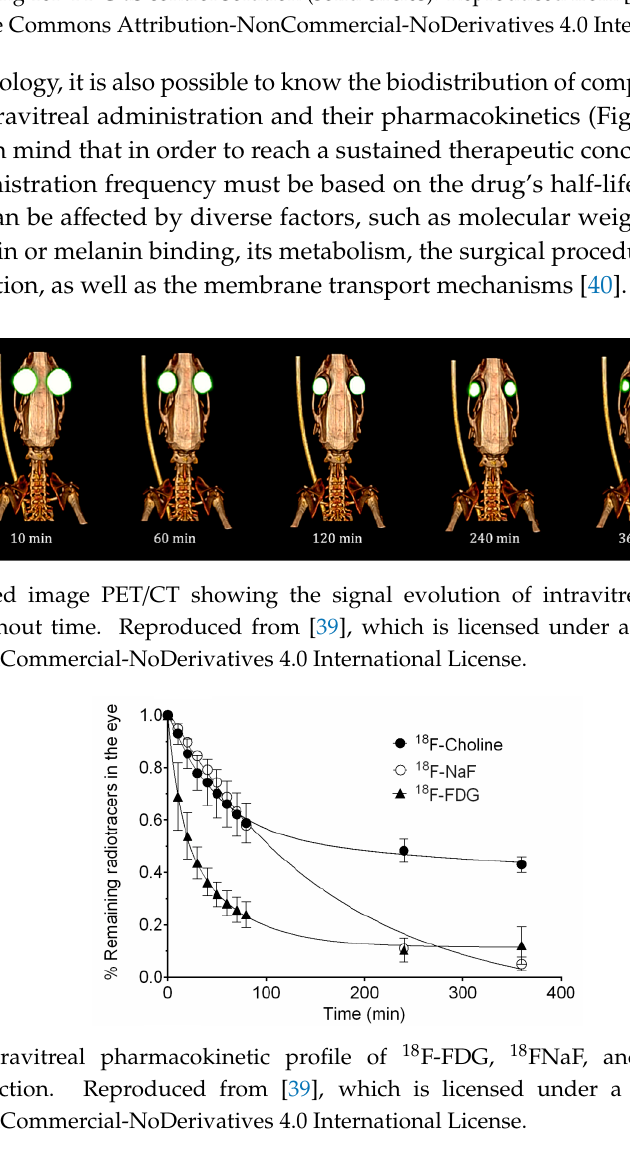
Figure 3. Kinetic profile of topical hydrogel labeled with 18F-FDG (blank circles) compared to a saline solution containing 18F-FDG as control solution (solid circles). Reproduced from [33], which is licensed